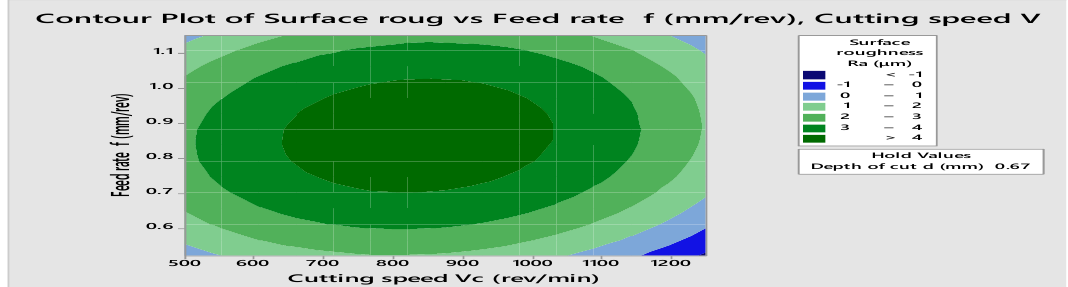
Figure 12: Contour plot for surface roughness with MBCF